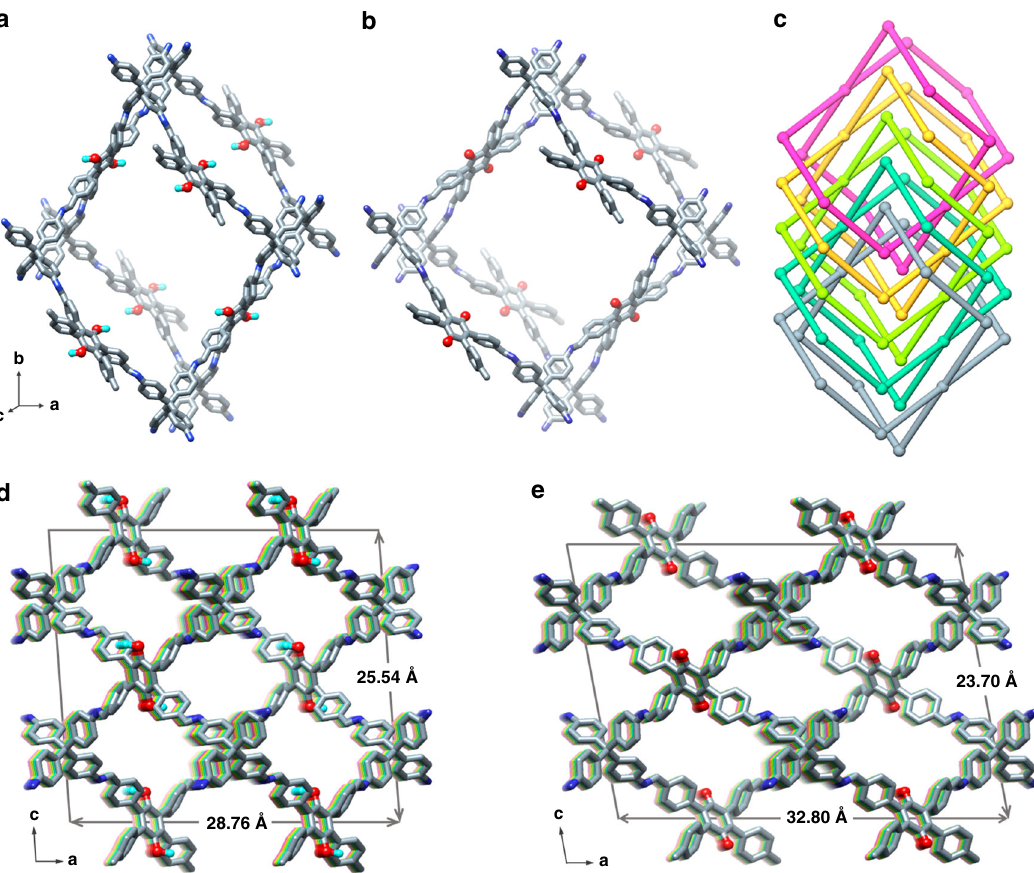
Fig. 3 Structural representations. a Single pts network of 3D-TPB-COF-HQ; b Single pts network of 3D-TPB-COF-Q; c fi ve-fold interpenetrated pts topology; the porous structure of ( d ) 3D-TPB-COF-HQ and ( e ) 3D-TPB-COF-Q. The carbon is colored in gray and nitrogen is in blue; all the hydrogen atoms are omitted for clarity except the hydrogens in the central benzene rings of 3D-TPB-COF-HQ. The balls in 3,6-position of the central ring of TPB are the atoms: H, cyan; O,